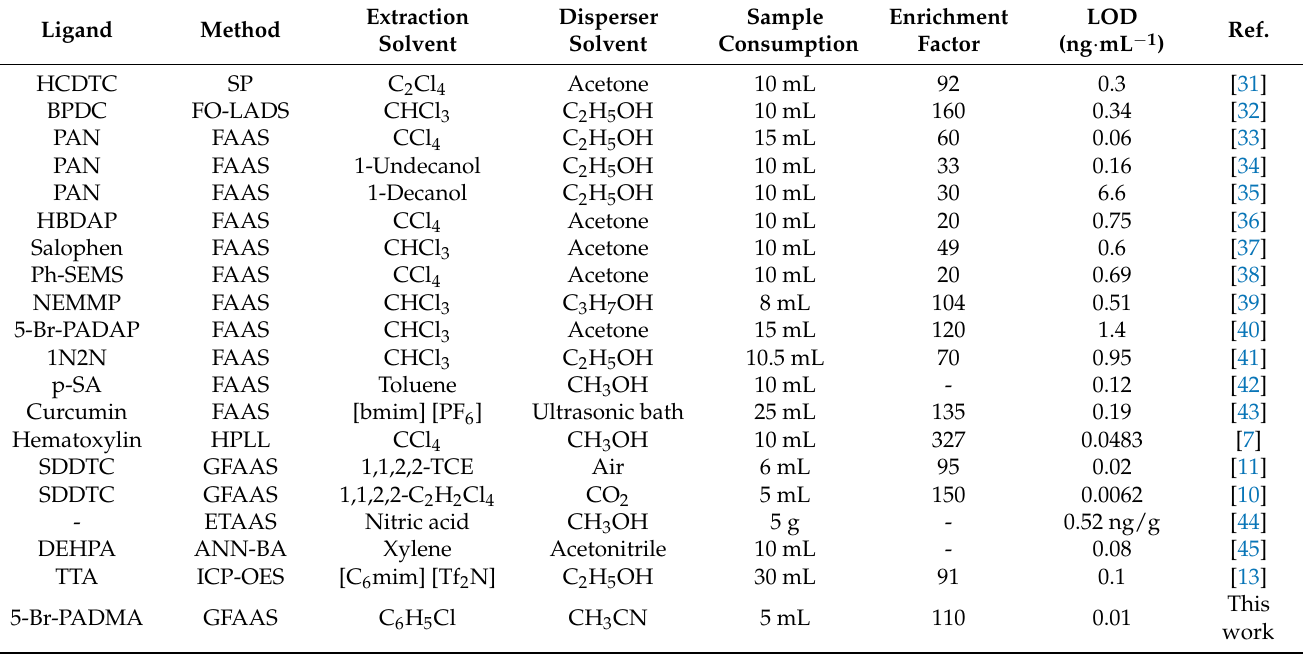
Table 3. Comparison of the proposed method with previously reported DLLME methods.